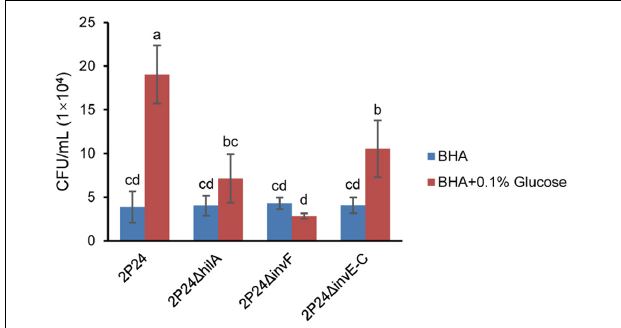
FIGURE 7 | The chemotactic responses of strain 2P24 and SPI-1 related mutants to glucose. Data are means of three replicates. Error bars represent SD. Means shown with the same letters are not different statistically at the 5% confidence level on the basis of Duncan’s multiple range